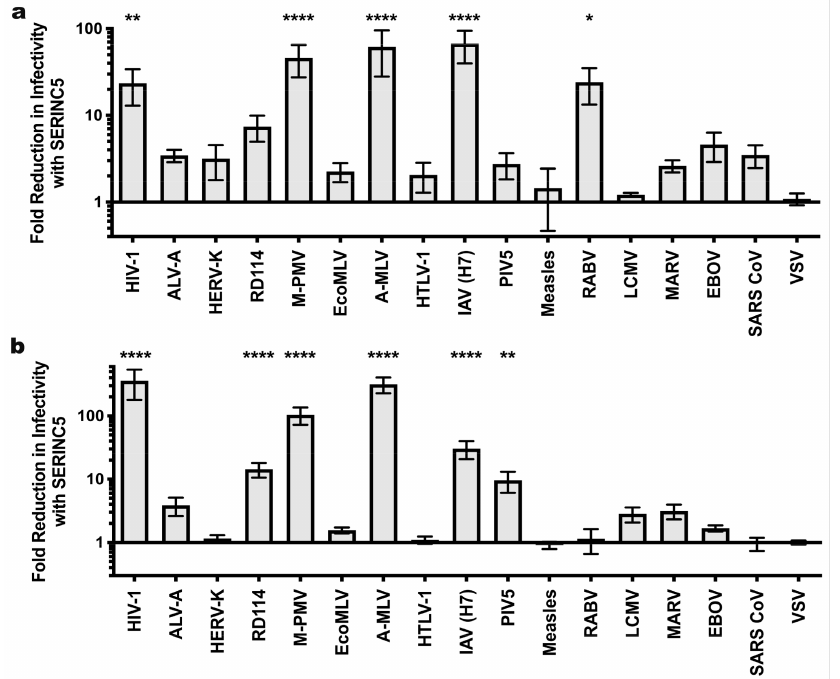
Figure 5. Sensitivity of MLV and M-PMV pseudotypes to SERINC5 antiviral activity. The effect of SERINC5 on the infectivity of glycoprotein pseudotypes using MLV ( a ) or M-PMV ( b ) cores was assessed as described in Figure 1. Plotted is the difference in infectivity between virus produced in the absence versus the presence of SERINC5 from at least three independent transfections. Statistical significance was determined via one-way ANOVA with Dunnett’s multiple comparisons post-test as for Figure 1. *, p < 0.05; **, p < 0.01; ****, p <